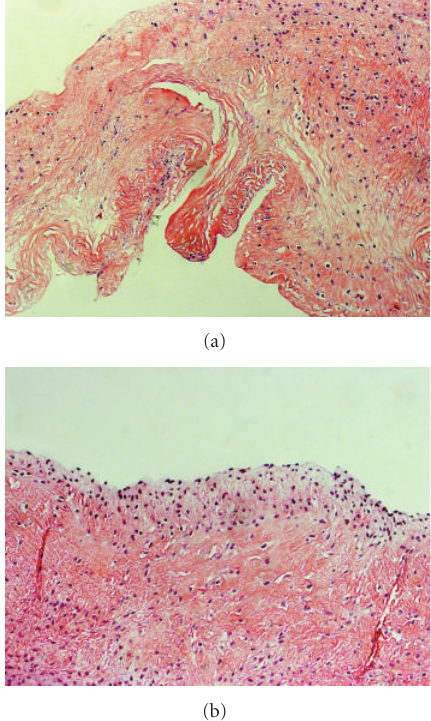
Figure 1: (a) H & E stain of a valve leaflet, confirming that the endothelium has been removed by 5-minute incubation with col- lagenase II followed by gentle swabbing. (b) Positive control sample showing an intact endothelium on a valve leaflet not treated with collagenase II and gentle swabbing. 10x